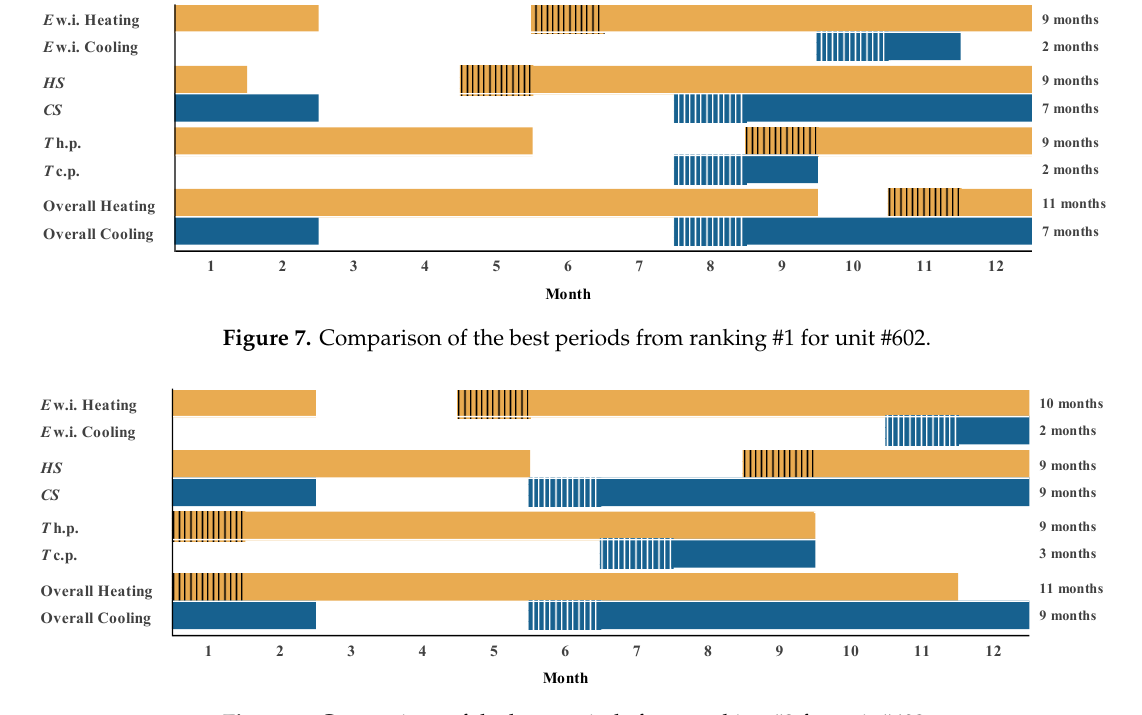
Figure 8. Comparison of the best periods from ranking #2 for unit #602.